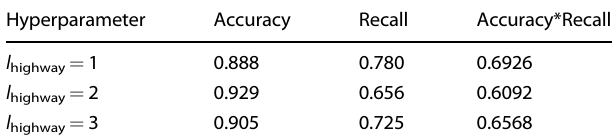
Table 3. Validation results for highway layers.